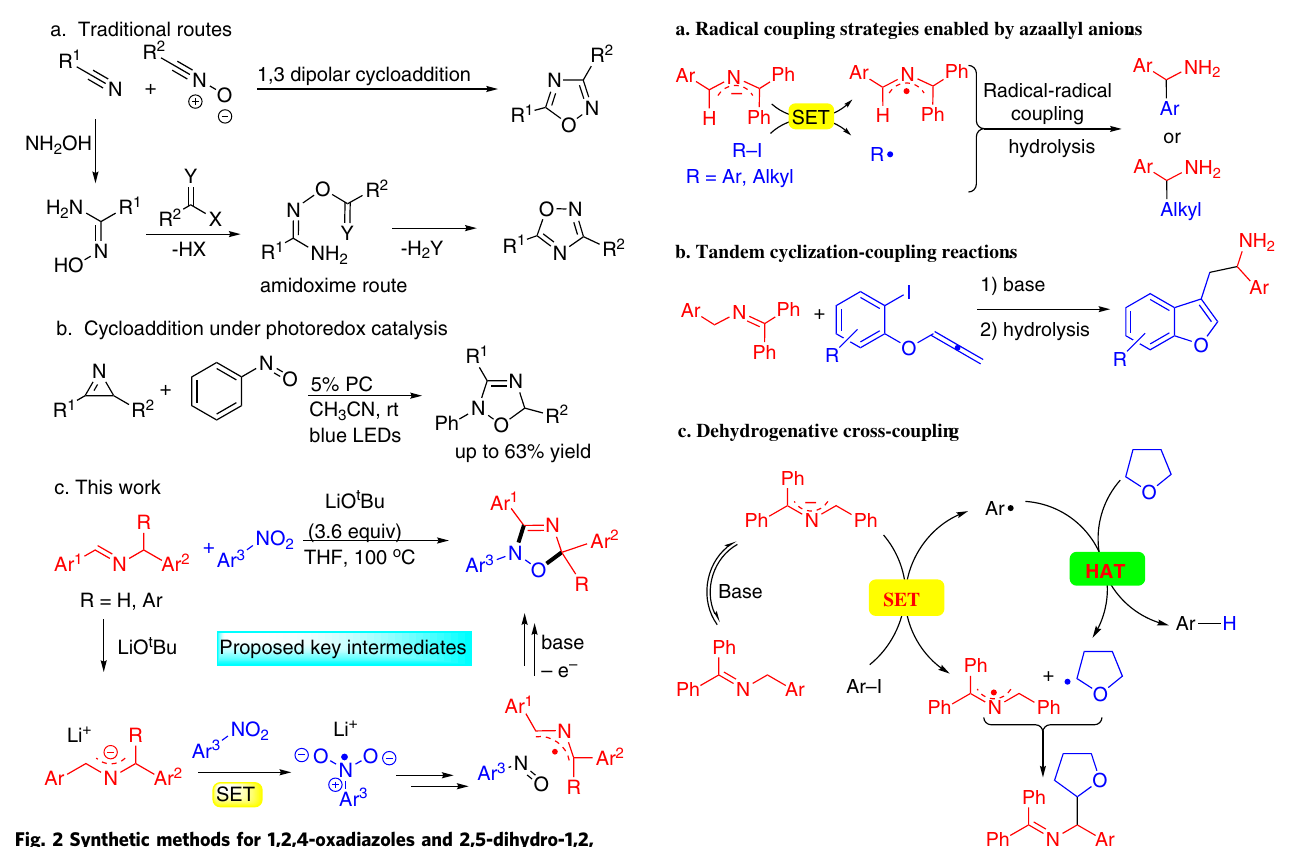
Fig. 2 Synthetic methods for 1,2,4-oxadiazoles and 2,5-dihydro-1,2, 4-oxadiazoles. a Traditional route oxadiazoles. b Cycloaddition under photoredox catalysis. c This work with key